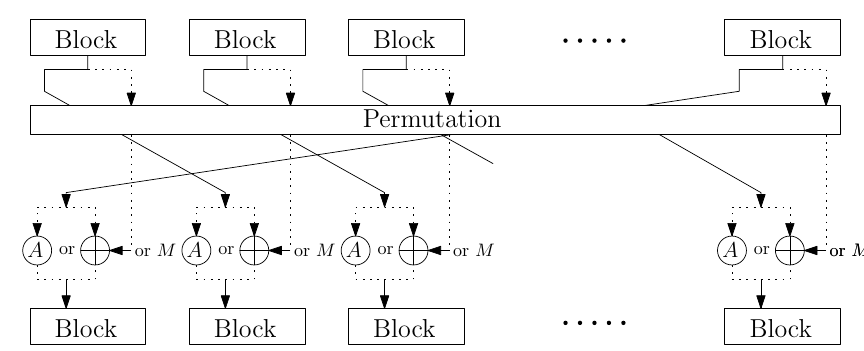
Figure 5: General construction of the round function. Dash lines mean that it can be possible to be absent or present in the